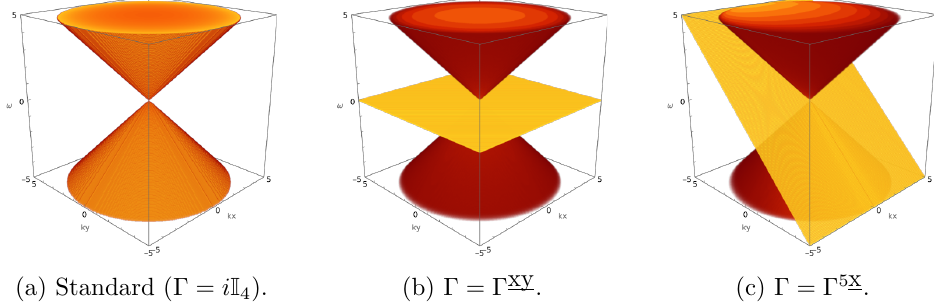
¯ ψ Γ ψ/ 2 where bdy